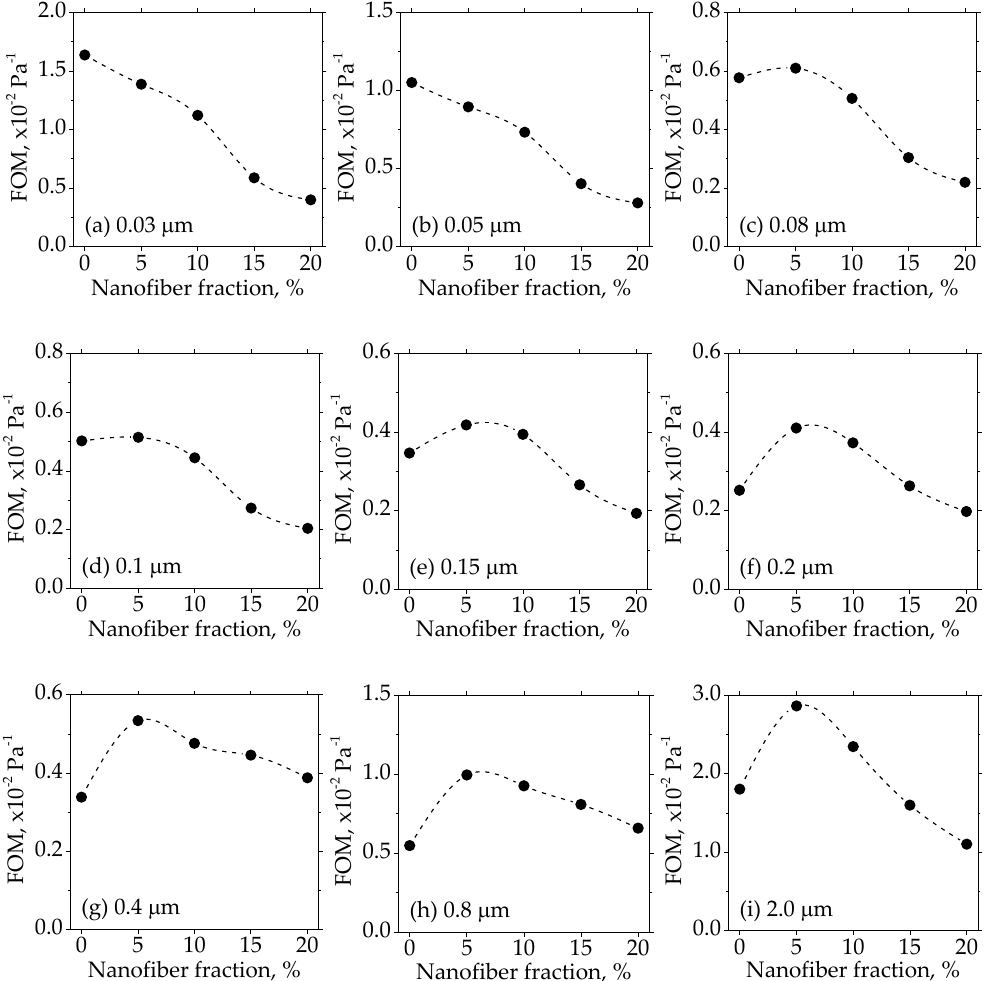
Figure 8. Figure of merit (FOM) of the filter paper against particles with different diameters.